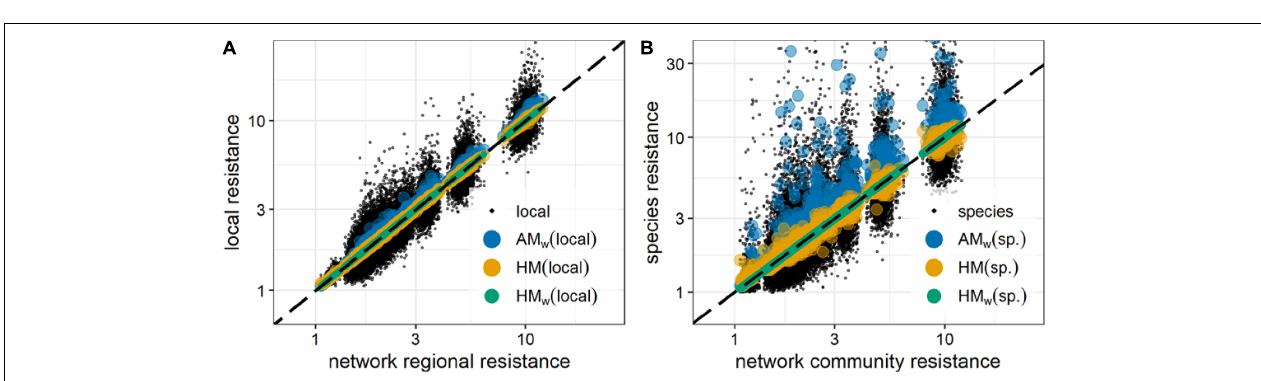
FIGURE 3 | Sample size required to estimate the growth rate of an ecological or spatial network from estimates at the nodes such that the standard error of the estimate is smaller than 10%. The required sample size mainly increases with the coefficient of variation of the node estimates of growth rate ( S R / M R ), and to a lesser extent with the coefficient of variation of the node biomass ( S N / M N ). Larger sampling sizes are required for more negative values of the cross-correlation between the biomass and the growth rate C N , R ( Table 1 ).